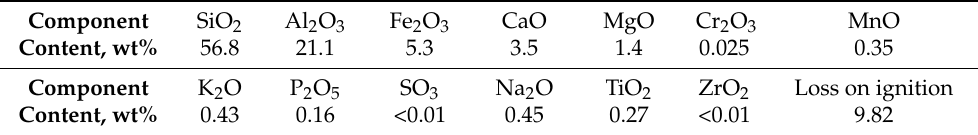
Table 1. Chemical composition of the Pliocene clays studied here.